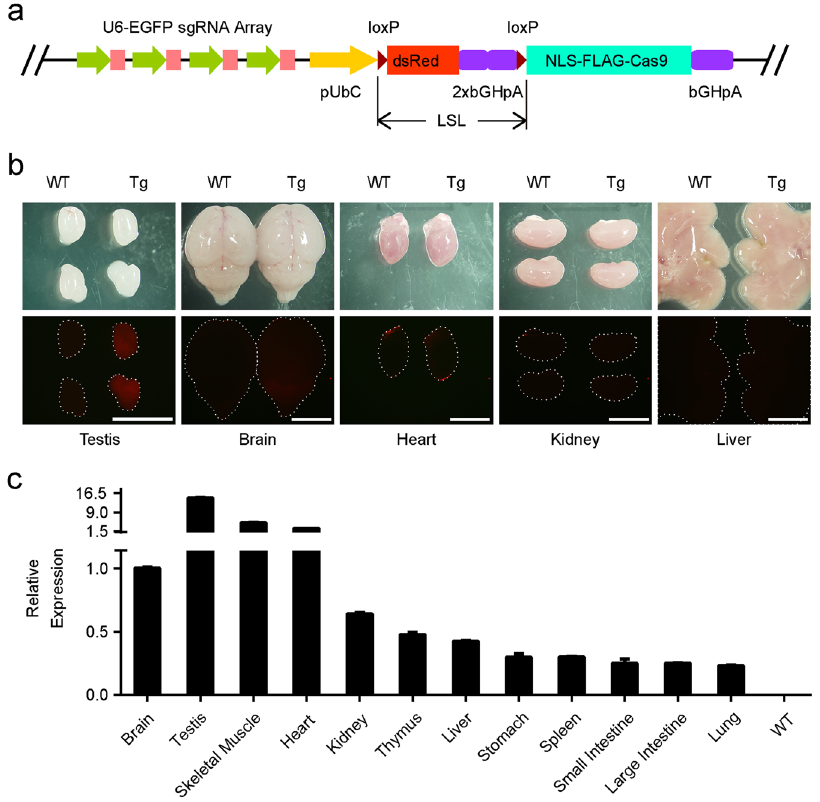
Figure 1. Generation of transgenic Cas9-based EGFP conditional KO mouse. ( a ) Schematic of sgRNAs EGFP - UbC-LSL-Cas9 transgenic vector. Four sgRNAs (pink) driven by U6 promoters (green arrowheads) were used to target independent sites of EGFP coding sequence. The Cas9 with nuclear localization signal (NLS) and FLAG tag was fused to LSL element and driven by UbC promoter. ( b ) DsRed fluorescence in organs of sgRNAs EGFP - LSL - Cas9 mouse (Tg) line 27. The upper panel shows organs in bright field. The lower panel shows dsRed fluorescence. Dotted lines indicate the organs invisible. Scale bar, 5 mm. ( c ) DsRed mRNA expression level in organs of mouse line 27 was analyzed by RT-PCR. The expression level of dsRed relative to β -actin in different organs was normalized to that in brain. WT mouse RNA mixture was absent of dsRed mRNA and used as a negative control (n = 3